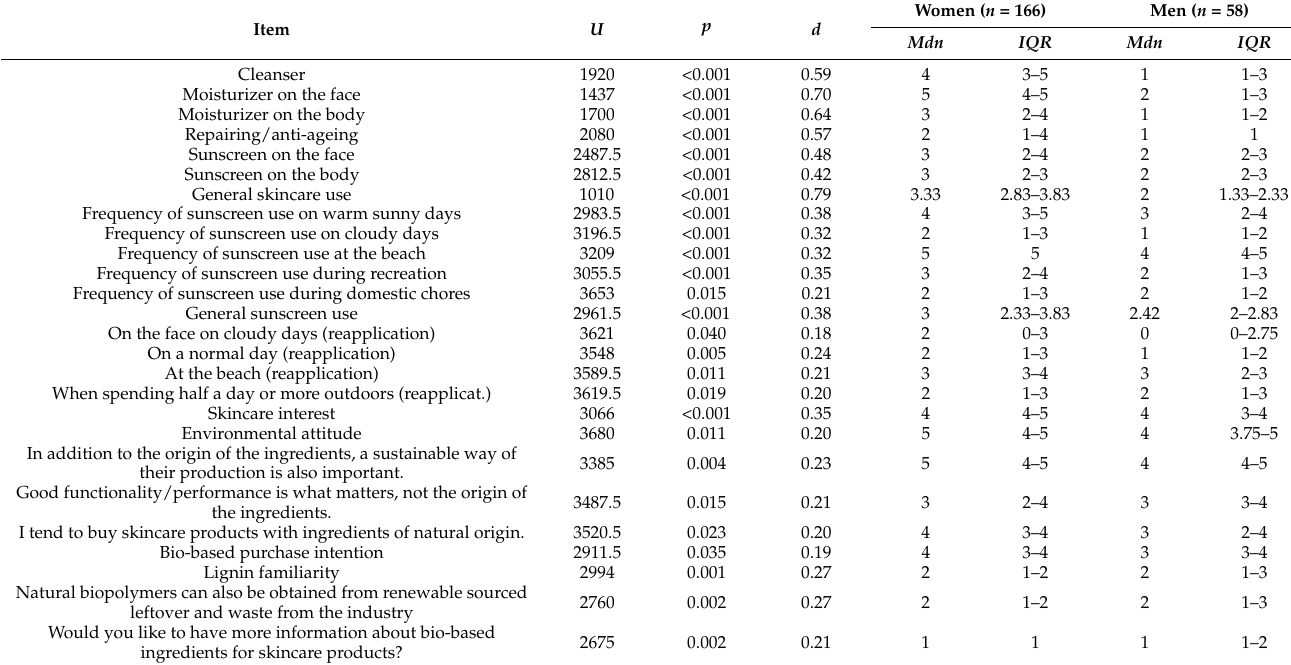
Table 4. Significant differences between subjects who identify as women and